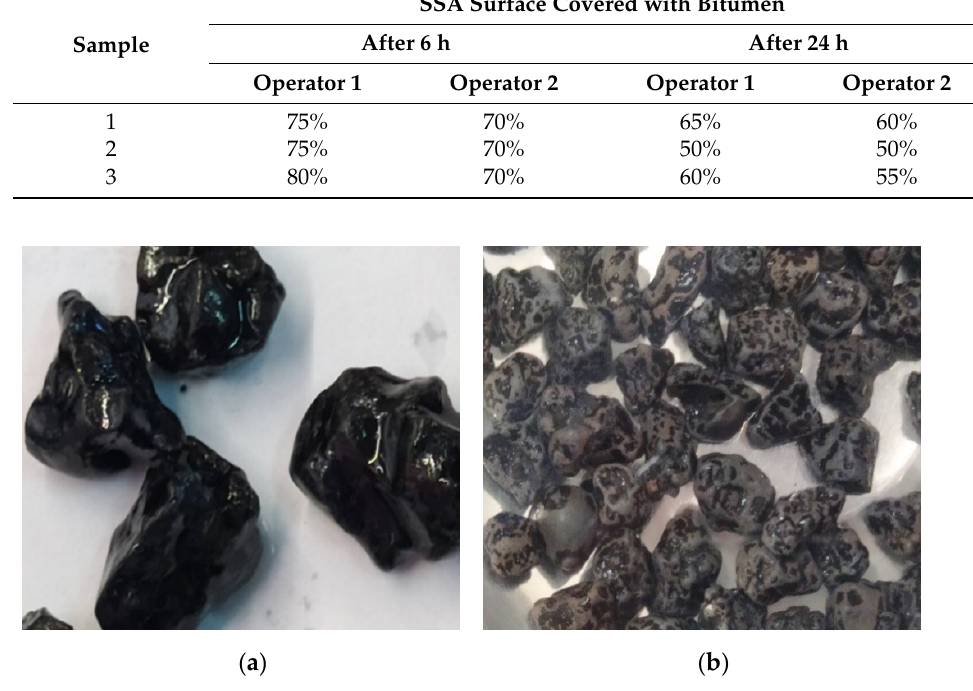
Figure 4. Examples of SSA aggregates surface covered with bitumen: ( a ) at the beginning of the affinity test; ( b ) after 24 h of exposure to test conditions.